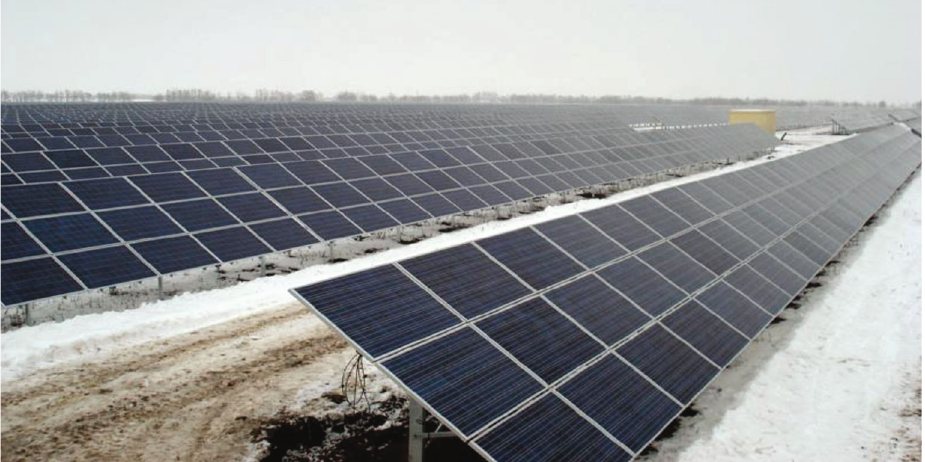
Figure 14: View of the PV park from Grojdibodu.